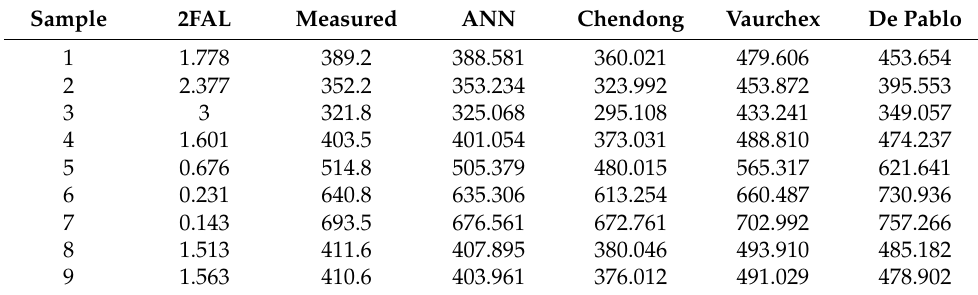
Table 2. Transformer case studies: DP.